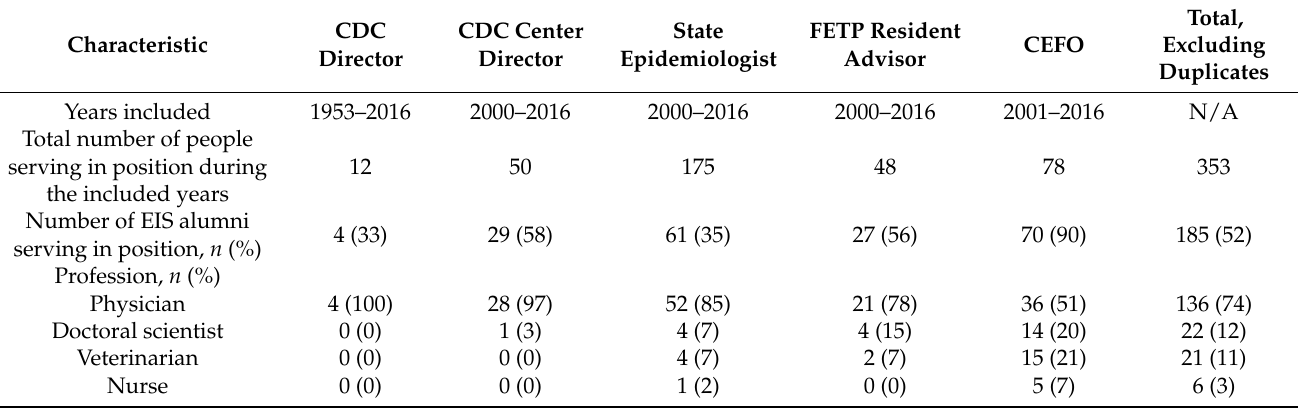
Table 1. Characteristics of Epidemic Intelligence Service (EIS) alumni in select public health leader- ship